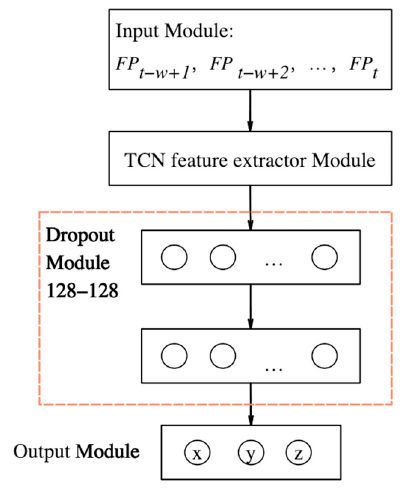
Table 3. Fingerprint slice dataset.